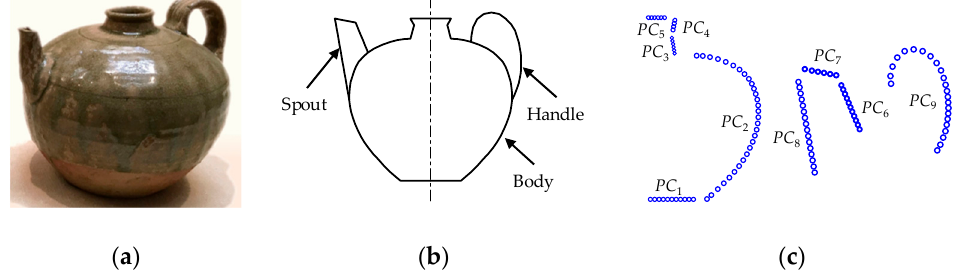
Figure 16. An Ewer from Seto ware. ( a ) A photograph of the Ewer [78]; ( b ) an illustration of the ewer; ( c ) individual point clouds.